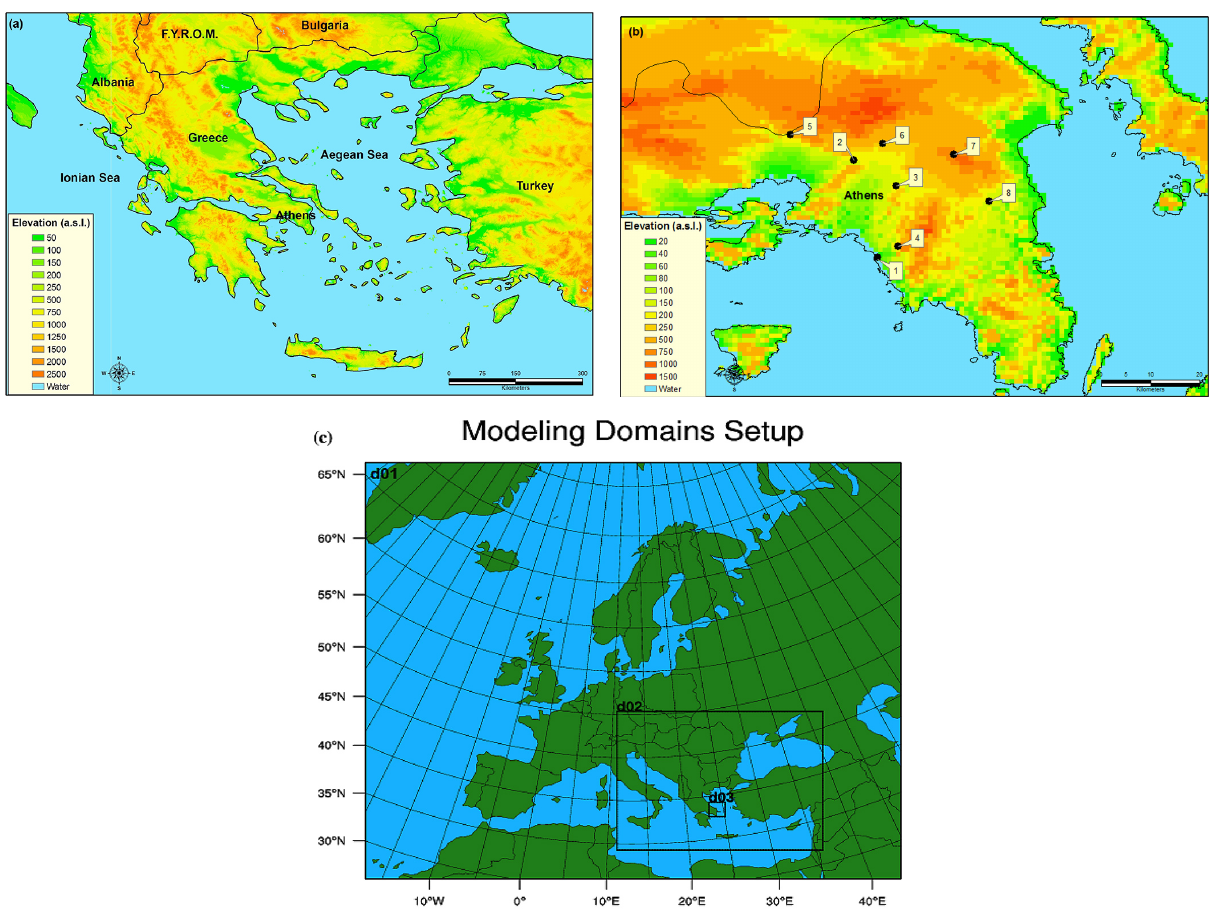
Fig. 1. Topography of (a) Greece, with identification of the city of Athens, and (b) GAA, with identification of the locations of the measure- ment sites. (c) Configuration of the three one-way nested domains used for the WRF simulations.